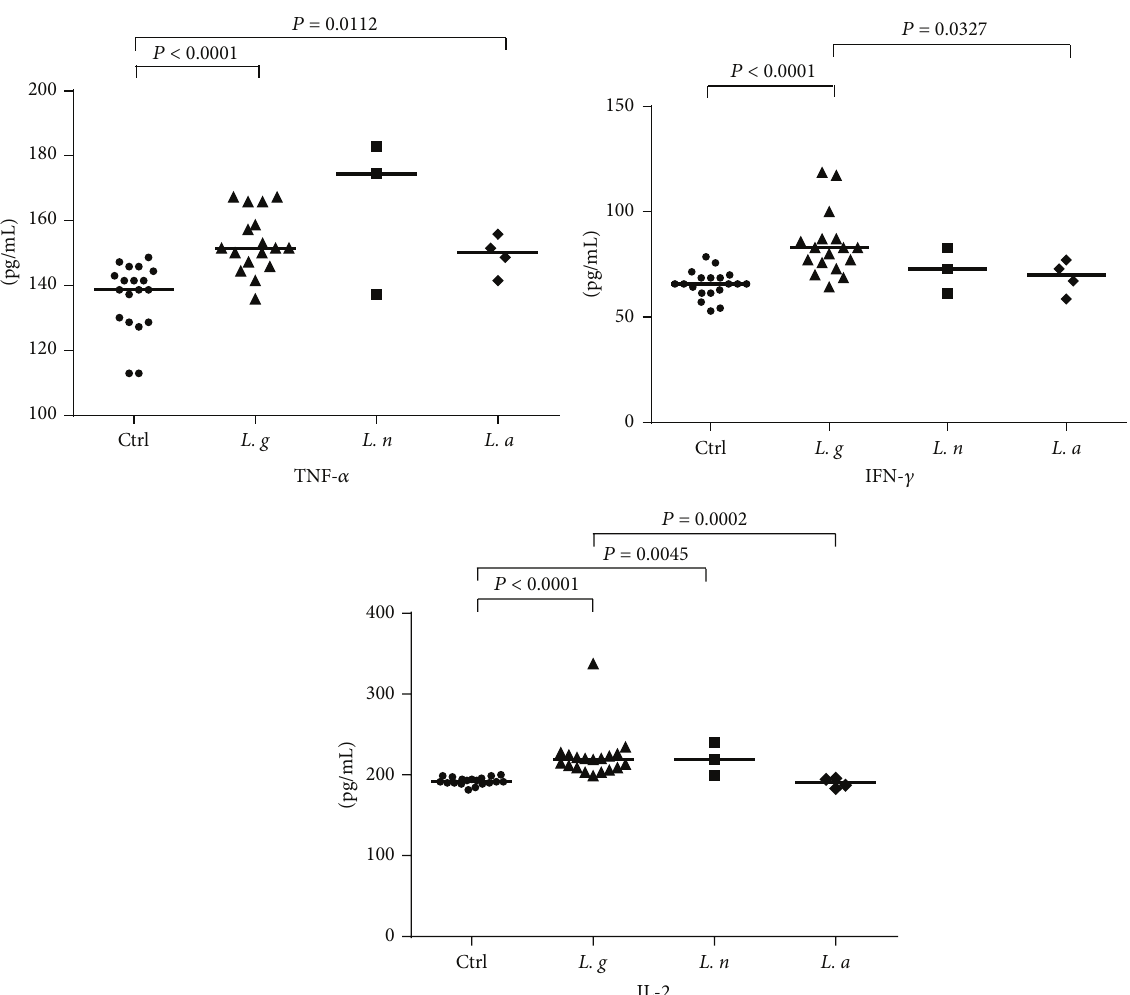
Figure1:IL-2,TNF- 𝛼 ,andIFN- 𝛾 levelsinserumsamplesfrompatientsinfectedwithdifferent Leishmania speciesandinnoninfectedcontrol. Cytokinelevels(pg/mL)werecalculatedforeachserumsample.Means(horizontallines)areshownforeachgroup.Ctrl:noninfectedcontrols; L. g : Leishmania guyanensis ; L. n : L . naiffi ; L. a : L. amazonensis